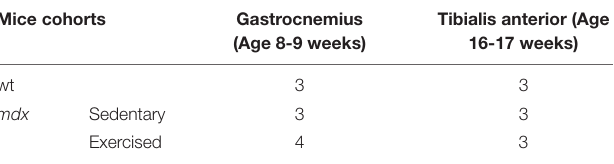
TABLE 1 | Wt and Mdx mice